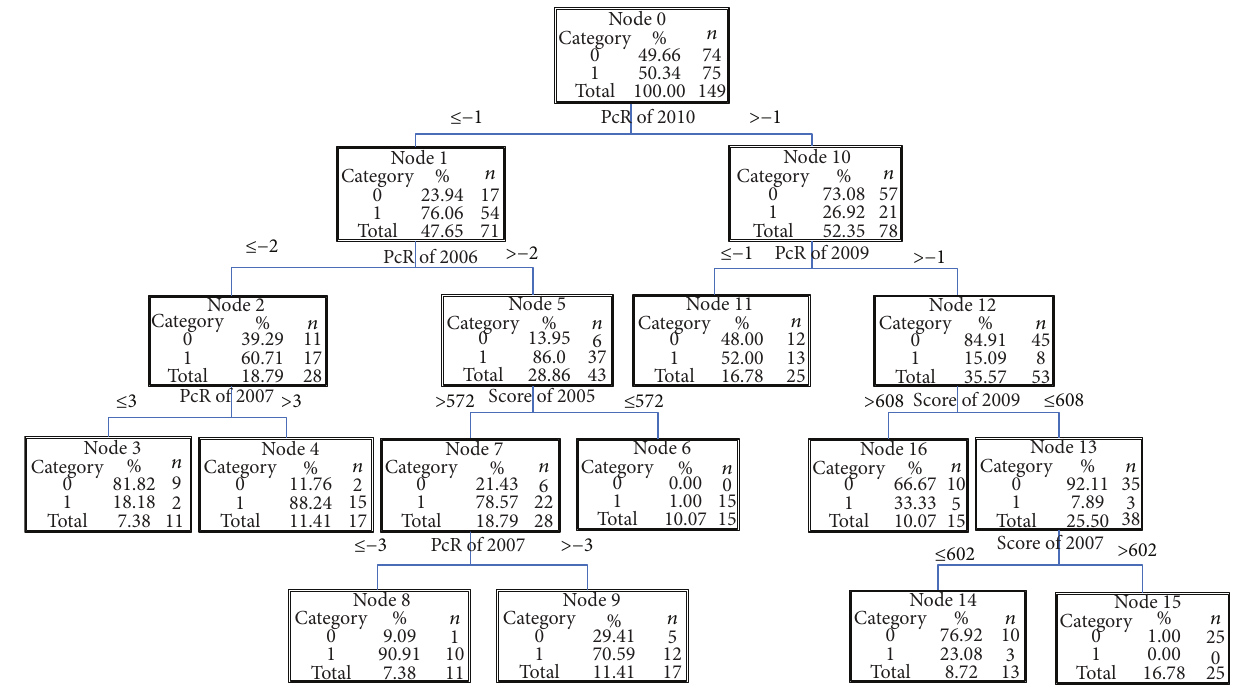
Figure 4: Decision tree of Hebei Province typed in “science.”